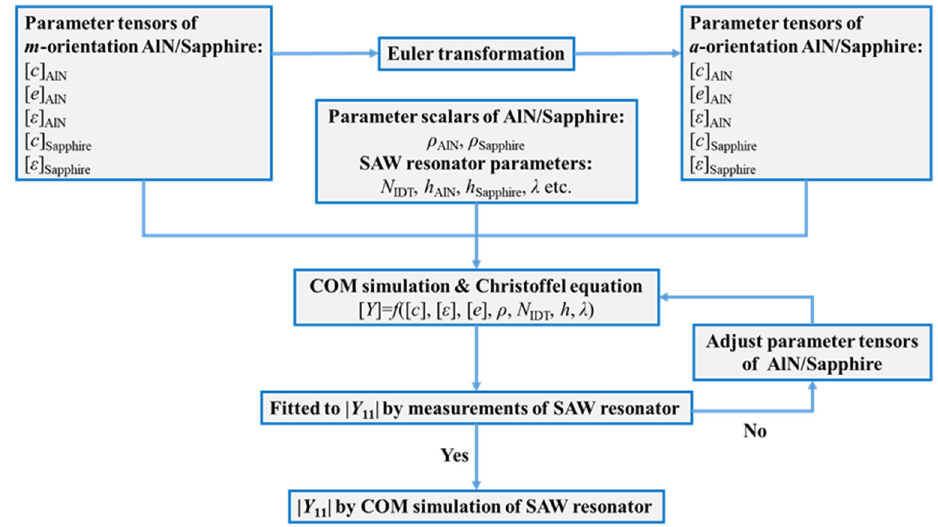
Figure 8. Flowchart of the simulation technique implemented, combining Euler transformation with